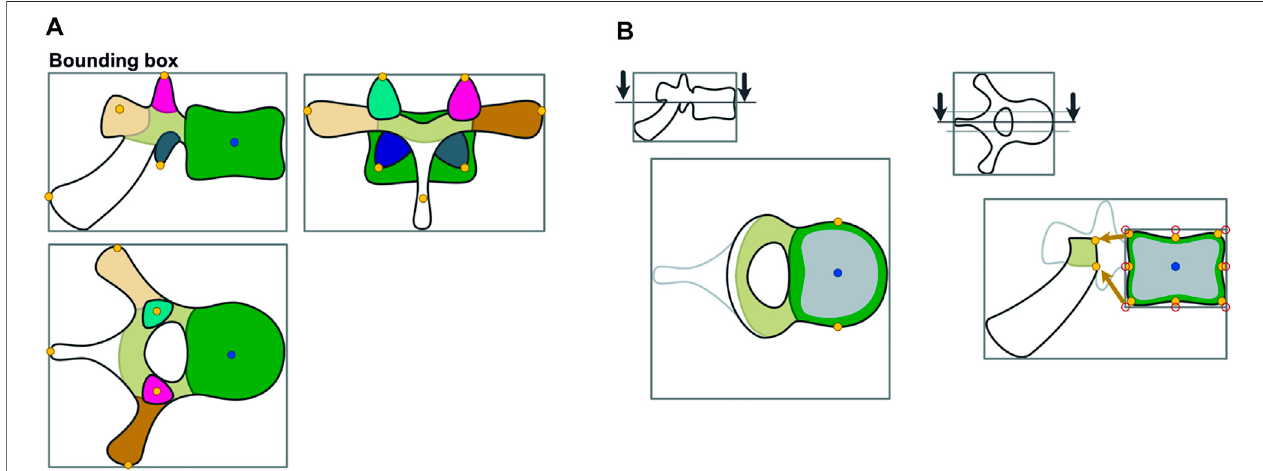
FIGURE 2 | Calculation of points of interest. The vertebra is divided in subregions, which are used further to identify landmarks based on geometrical extreme values (A) . Horizontal and auxiliary planes are inserted to identify points of interest of the vertebral body via a projection of the border points of a bounding box on the respective subregion (B) .